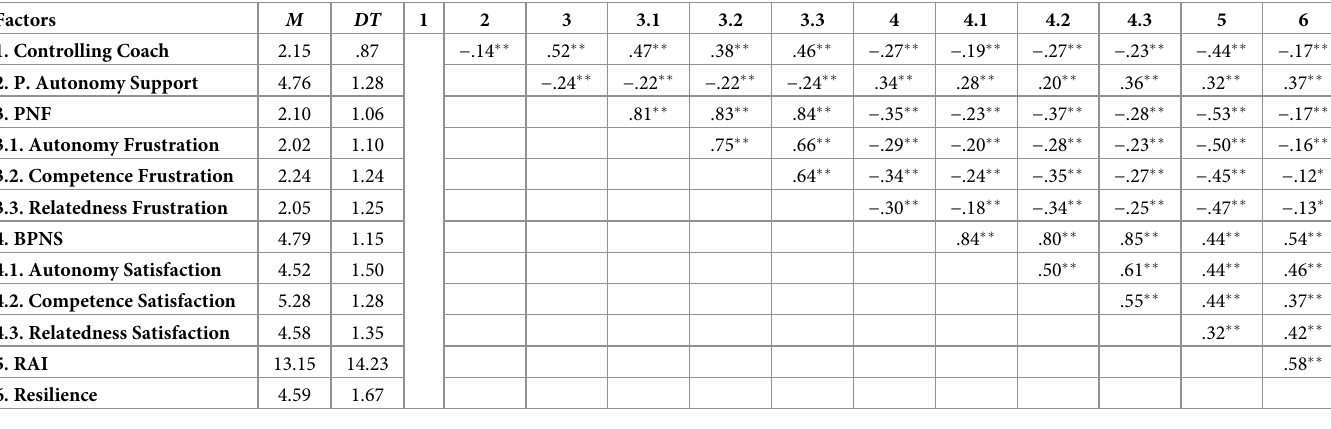
Table 1. Descriptive statistics and correlation analysis between the factors.